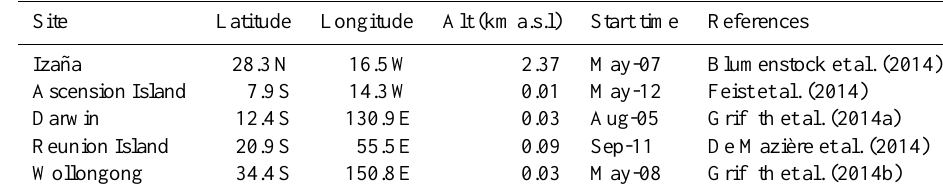
Table 2. The locations and start times of TCCON sites.